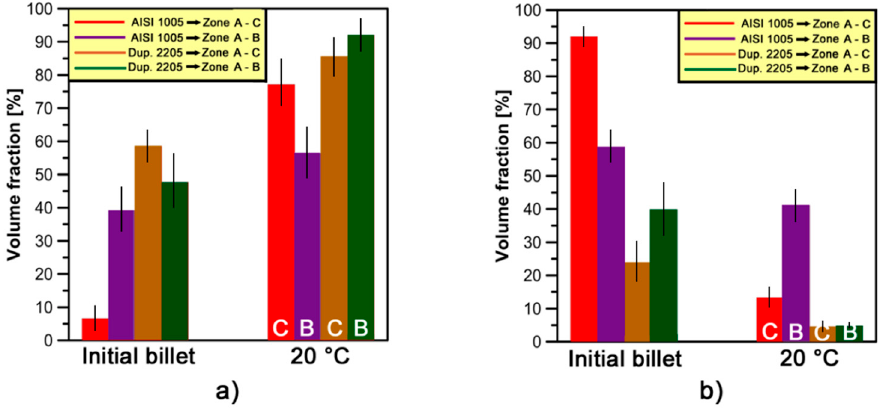
Figure 7. Volume fractions of: ( a ) LABs; and ( b ) HABs developed in α -phase for AISI 1005 and DDS 2205 samples at 20 °C and different strain levels.